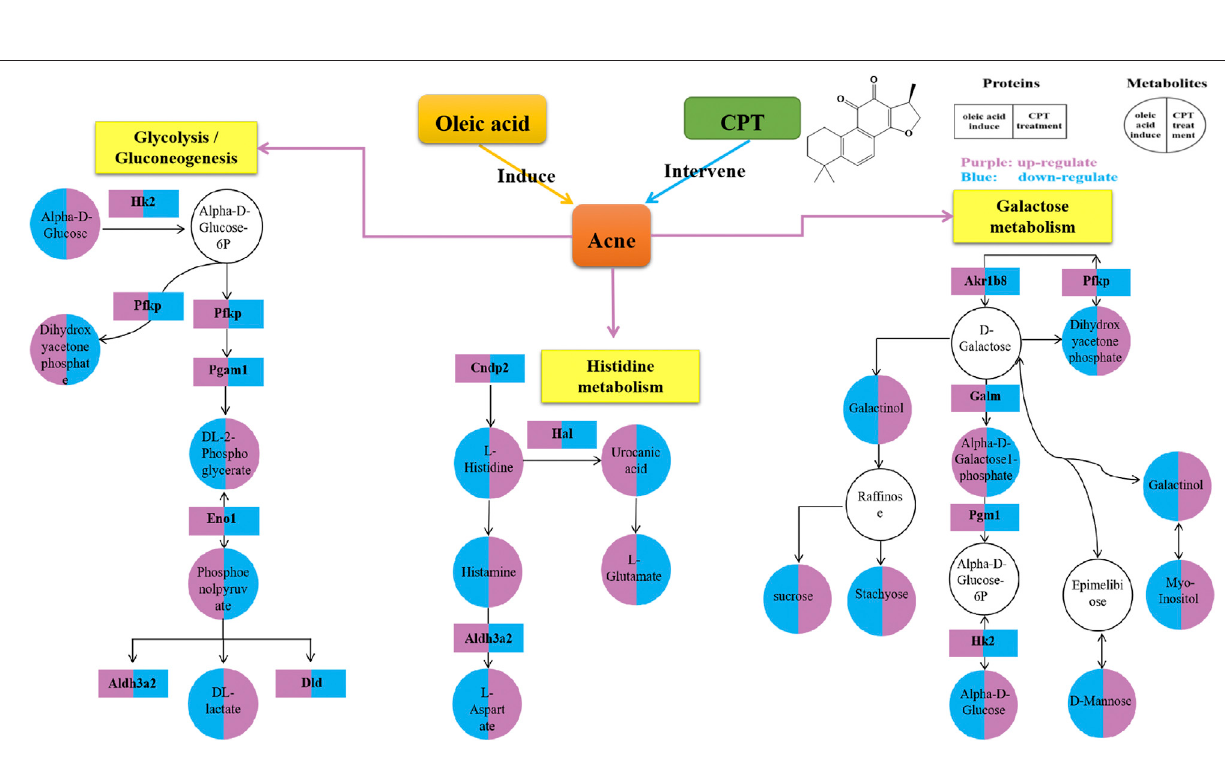
FIGURE 11 | Network for a mechanistic explanation of the proteomics and metabolomics analyzes. versus the MC group, the purple and blue represent up- regulation and down-regulation, respectively. The yellow color represents the metabolism pathway. The DEPs and DEMs are represented by rectangles and circles,